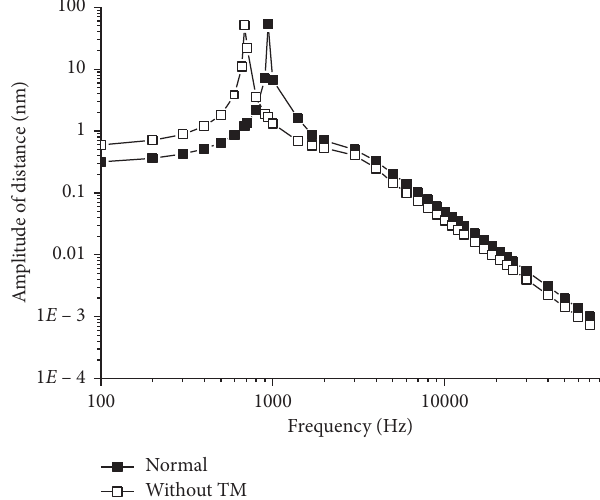
Figure 8: The effect of the lack of